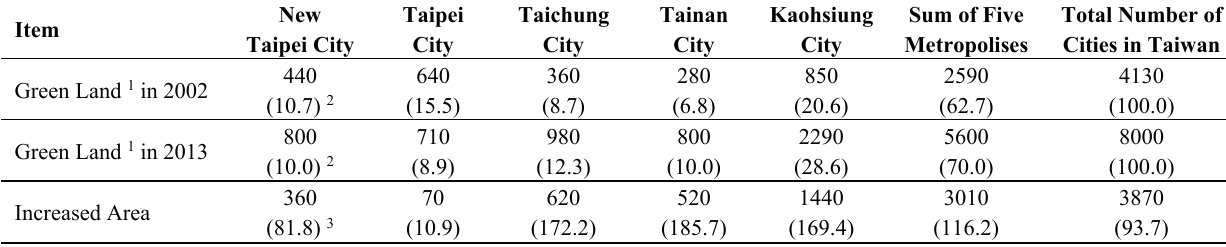
Table 4. Green Land constructed by five metropolises in Taiwan in 2002 to